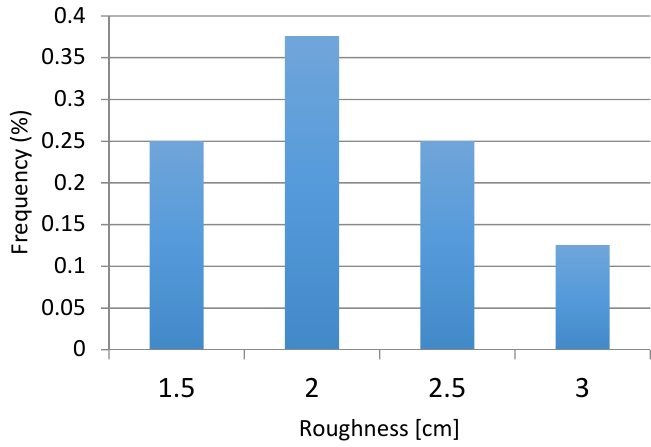
Figure 4. Distribution of roughness extracted from image processing.